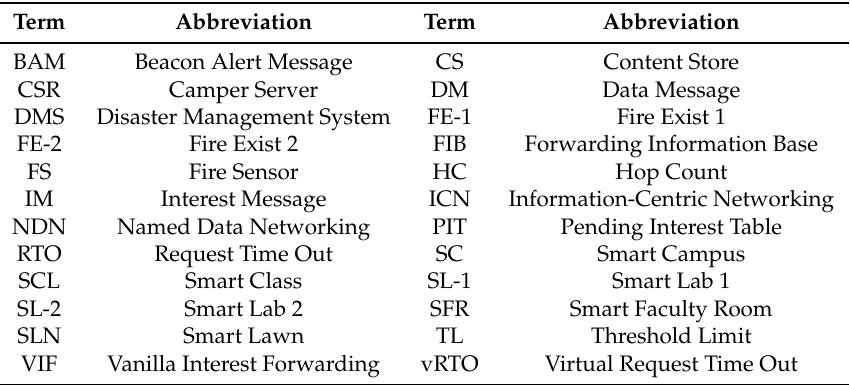
Table 1. List of Key Terms